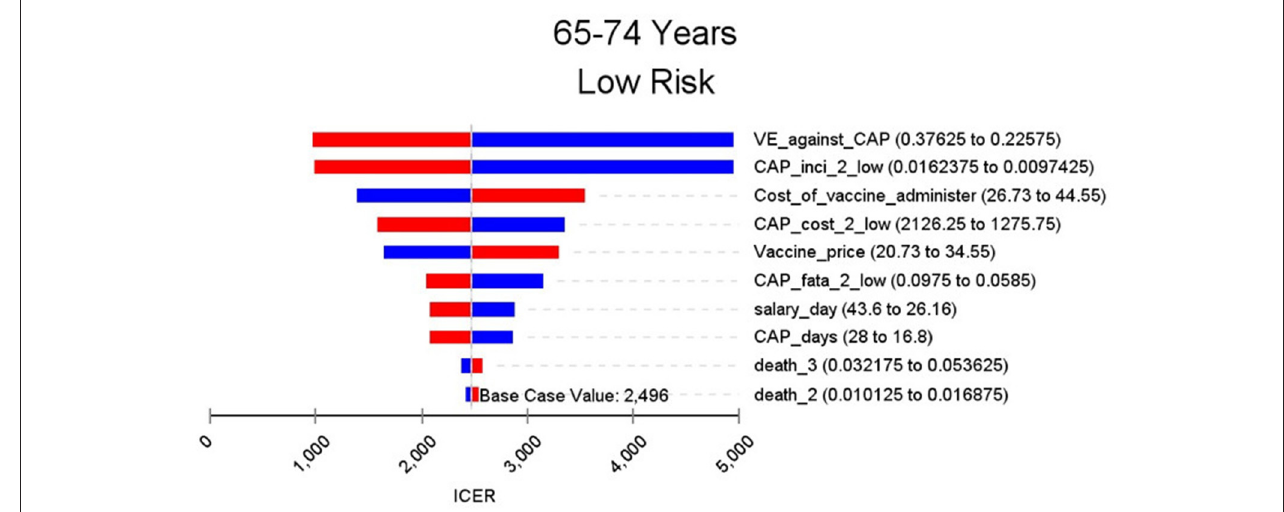
FIGURE 4 | Sensitivity analysis in group 65–74 years and low risk.